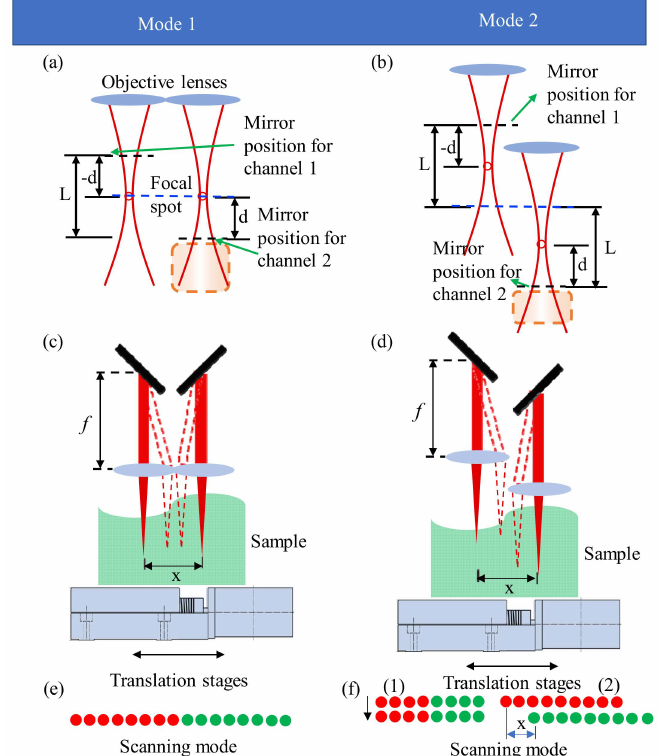
Figure 2. ( a , b ) show position relationships between the focused sample beams and the reference mirrors in mode 1 and mode 2, respectively; ( c , d ) are schematic diagrams of sample arms in the experiment setup; ( e , f ) are scanning modes of two imaging modalities. In ( a , b ), the blue dotted lines represent the positions of coordinate origin along the depth z direction, and the black dotted lines represent the positions of the zero optical path di ff erence of each